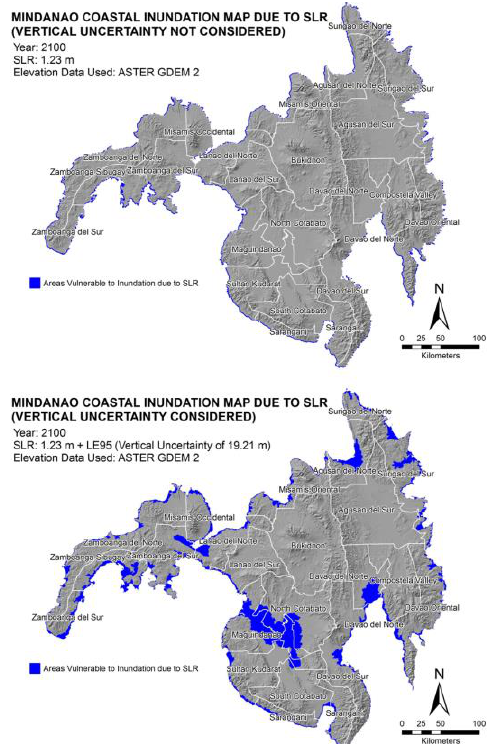
Figure 5. Map of inundations due to SLR of 1.23 using ASTER GDEM2 with and without considerations of vertical uncertainties computed using all GCPs.